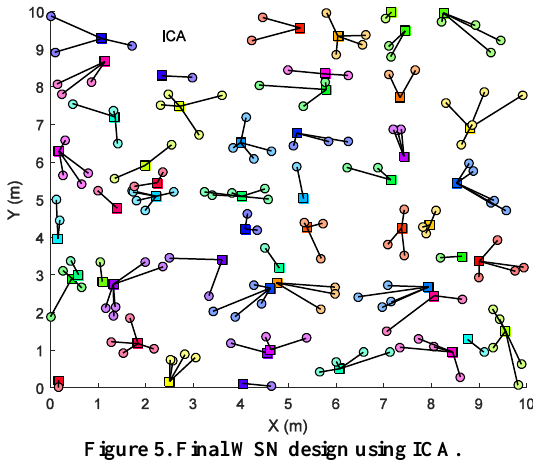
Figure 5. Final WSN design using